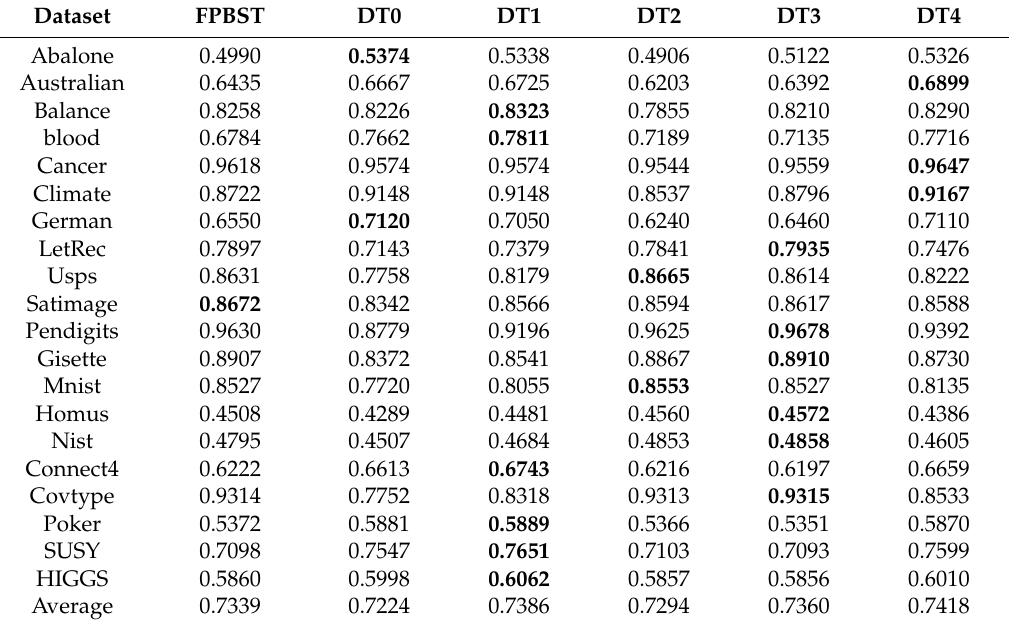
Table 4. Accuracy results of the proposed methods DT0–DT4 compared to that of the FPBST, using 10-fold cross-validation.